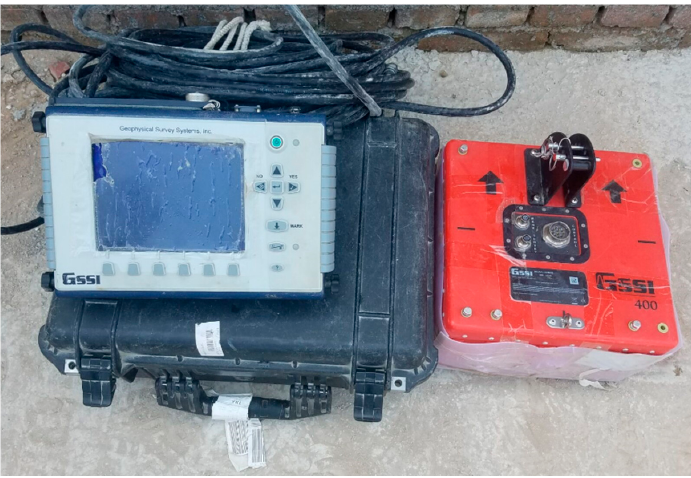
Figure 4. Ground-penetrating radar. Processes 2018 , 6 , x FOR PEER REVIEW